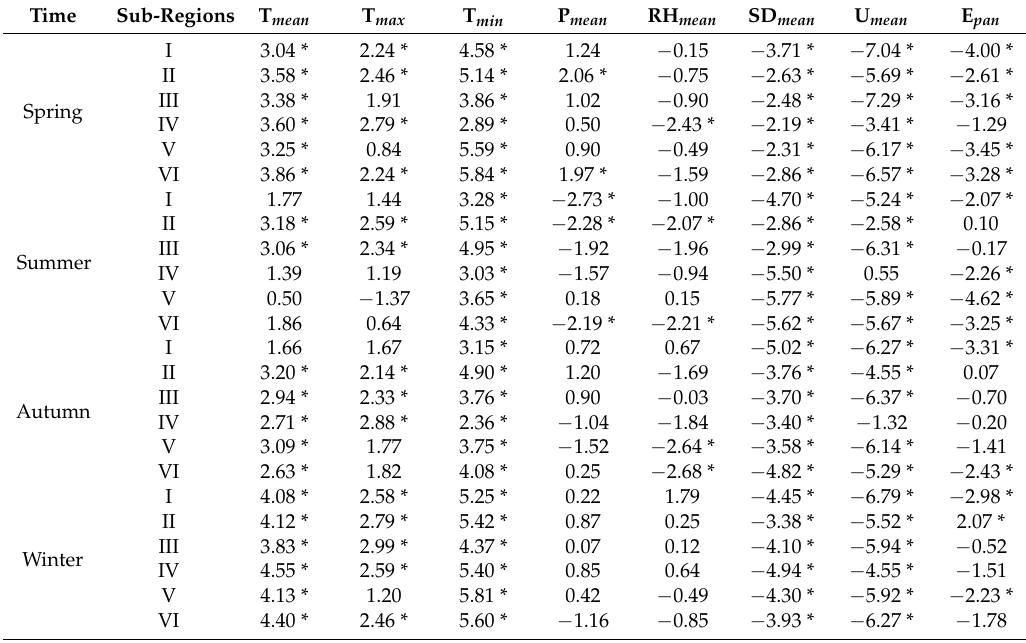
Table 3. Z-Value of the Mann-Kendall test on the meteorological variables ( α = 0.05). Time Sub-Regions T mean